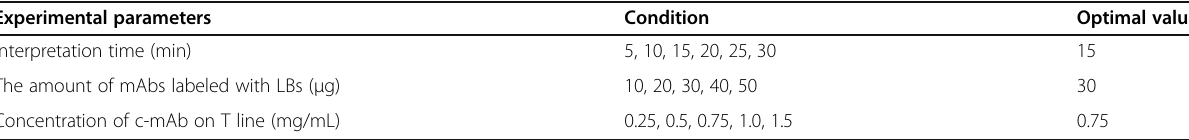
Table.1 Optimization of the LBs-LFIA condition